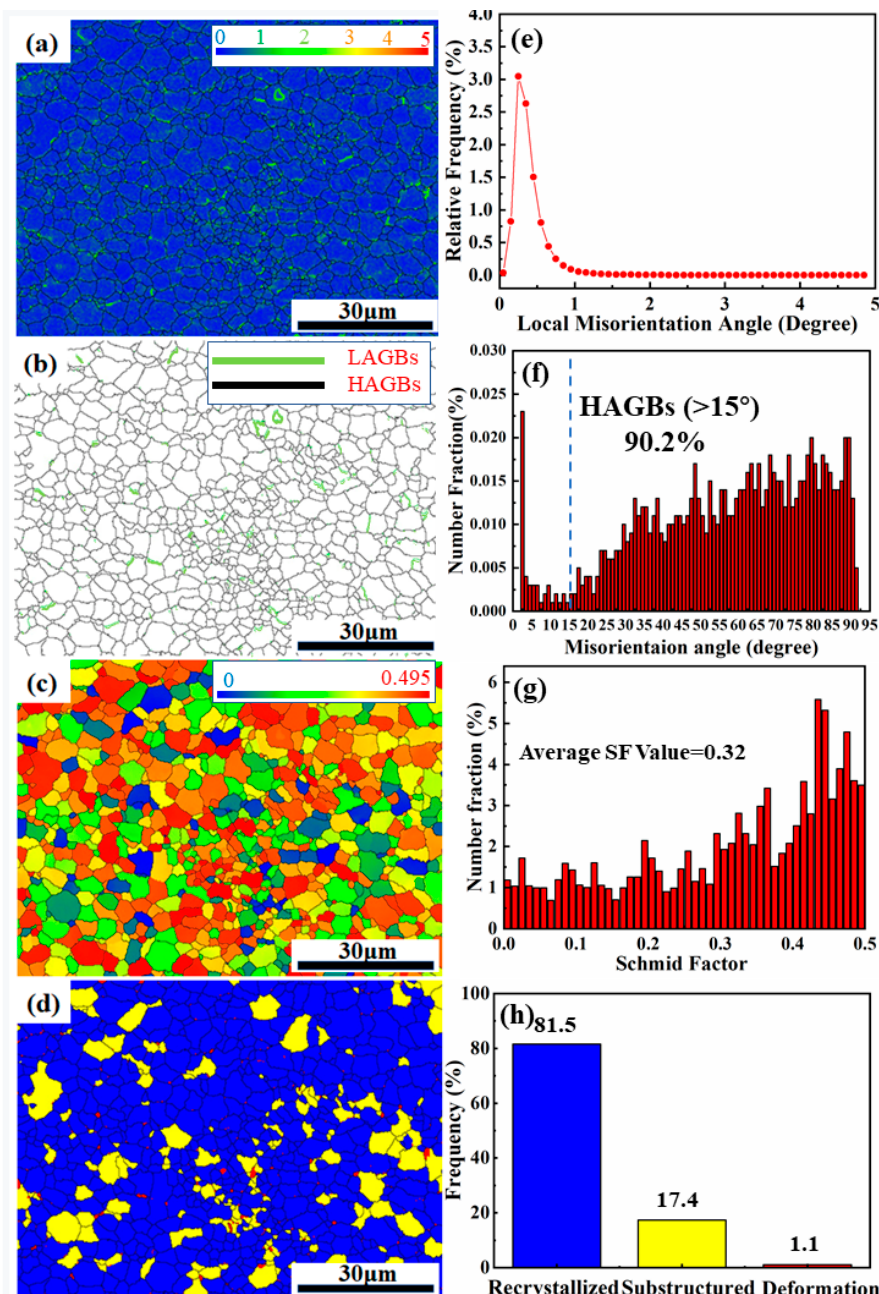
Figure 7. EBSD of AS41 Mg alloy sample along the cross-section: ( a , e ) the kernel average misori- entation map, ( b , f ) grain boundary misorientation map, ( c , g ) Schmid factor distribution, ( d , h ) the recrystallization distribution.